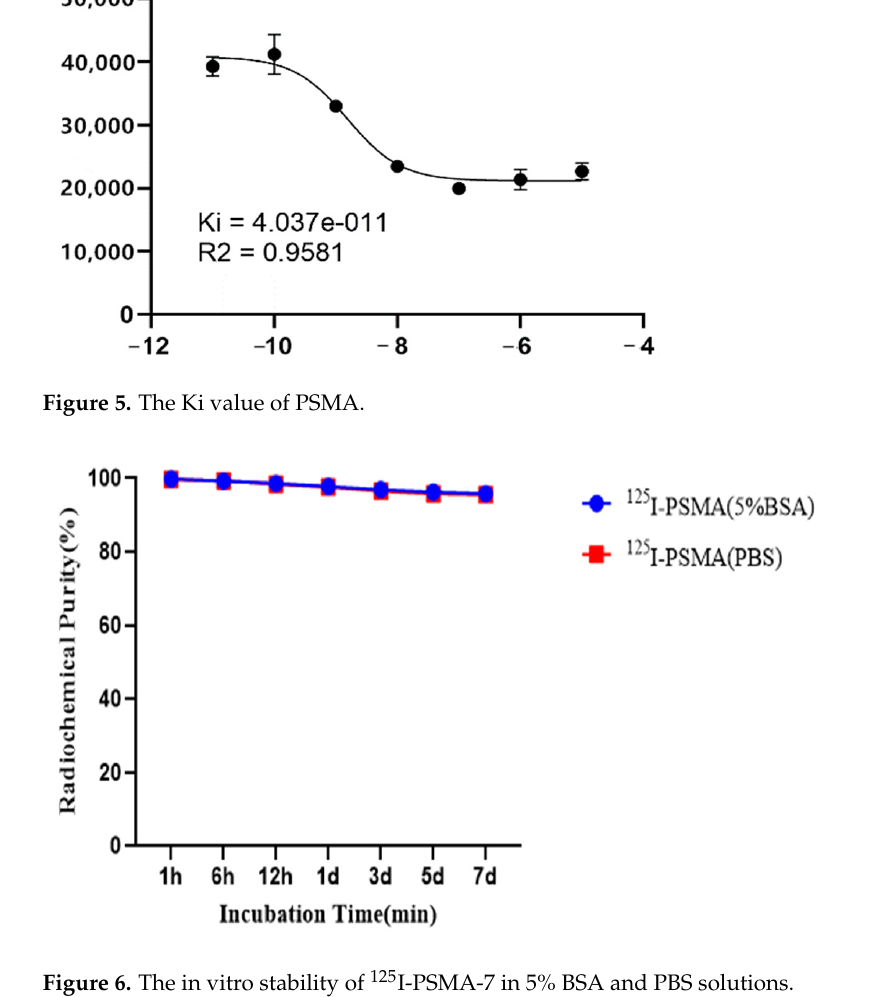
Figure 6. The in vitro stability of 125 I-PSMA-7 in 5% BSA and PBS solutions.